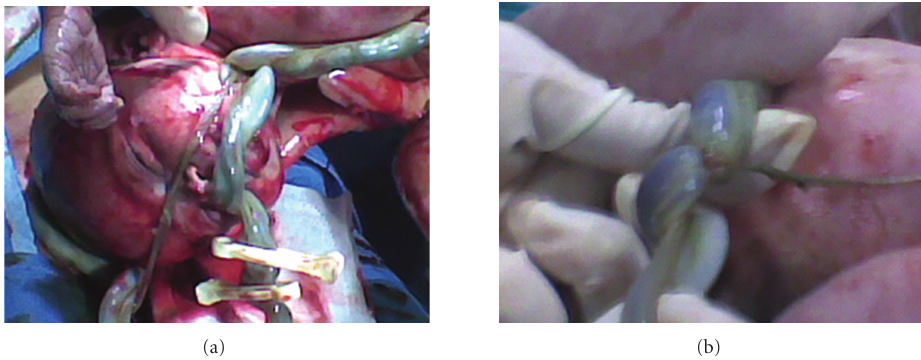
Figure 2: Umbilical cord strangulation: (a) Entrapment of umbilical cord by amniotic band. (b) Visualization of amniotic